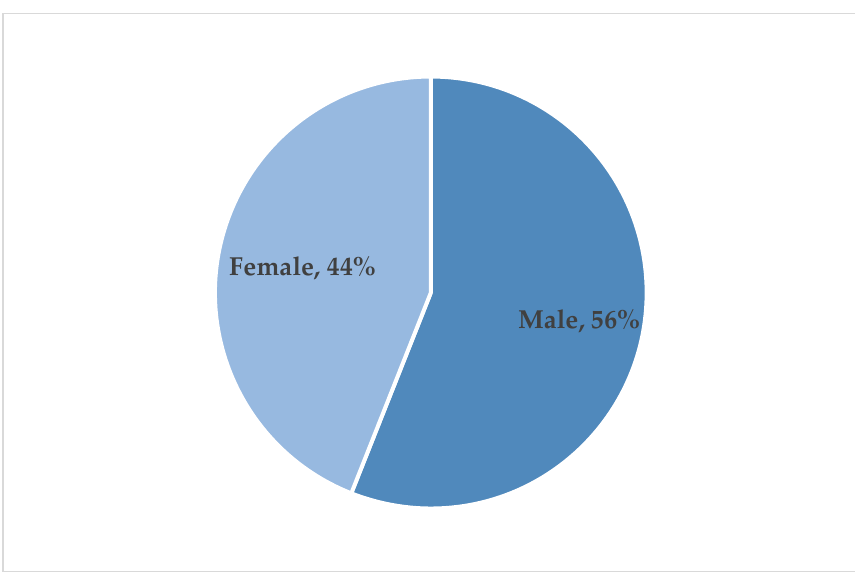
Figure A2 . Sex distribution of study participants at Yangon General Hospital, Myanmar, in 2018.